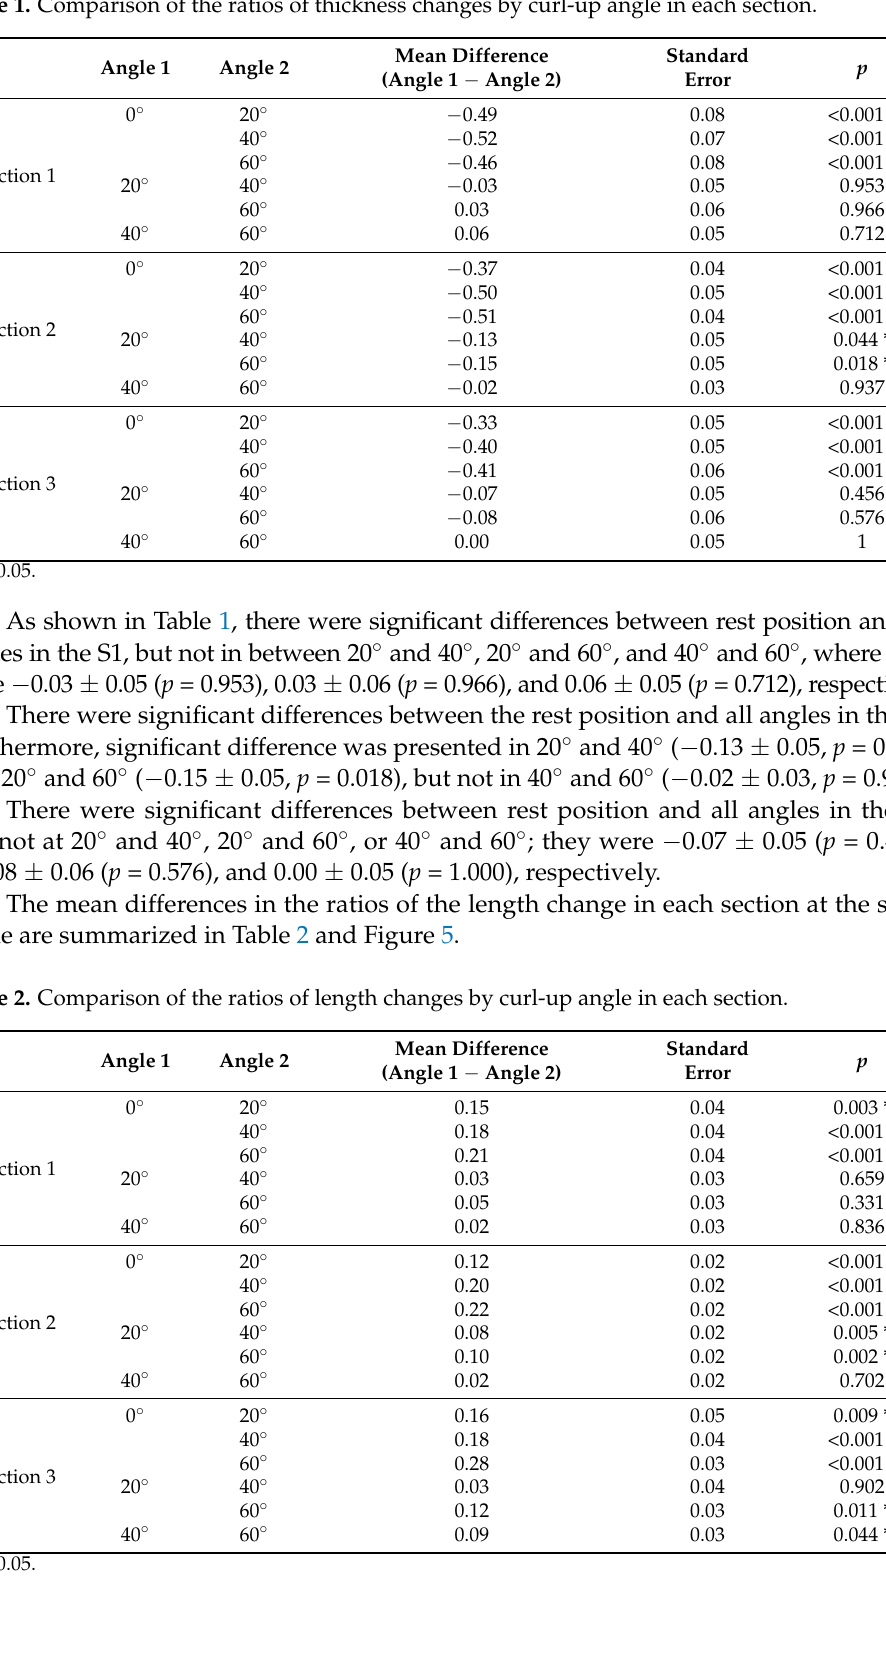
Table 1. Comparison of the ratios of thickness changes by curl-up angle in each section.